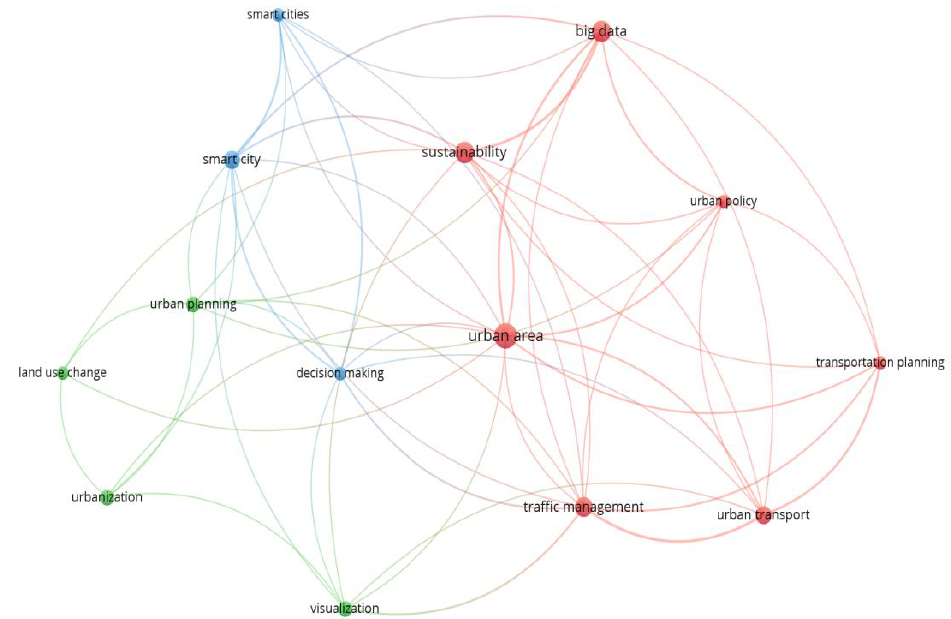
Figure 2. Map of word clouds on data-driven urban management.